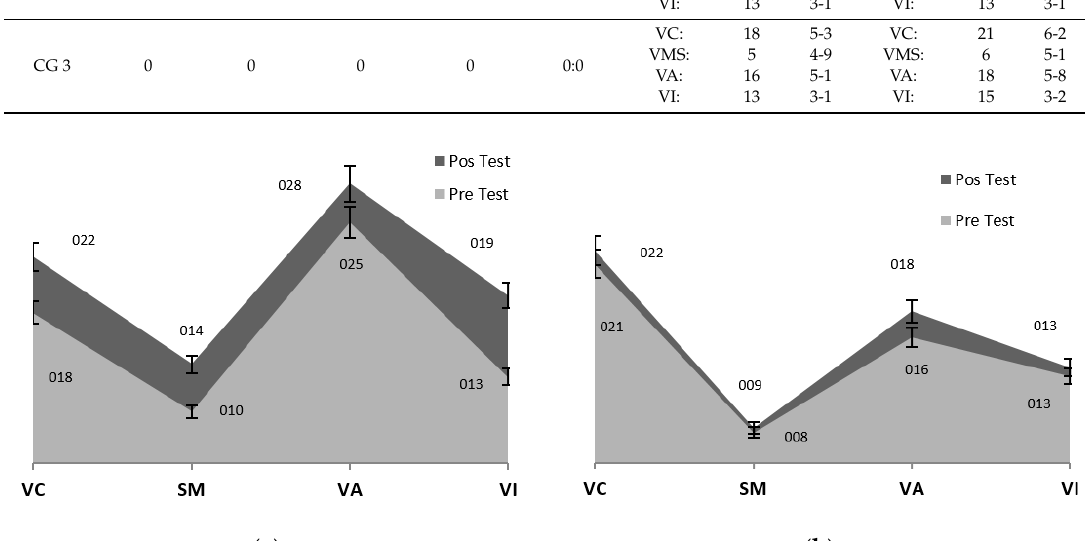
Figure 4. Pre / Post-Test Results from the ITPA sub-test in EG and CG. ( a ) Pre / Post Test EG (Error bar 5%); ( b ) Pre / Post Test CG (Error bar 5%). (VC = Visual Comprehension; SM = Sequential Memory; VA = Visual Association; VI = Visual Integration.)